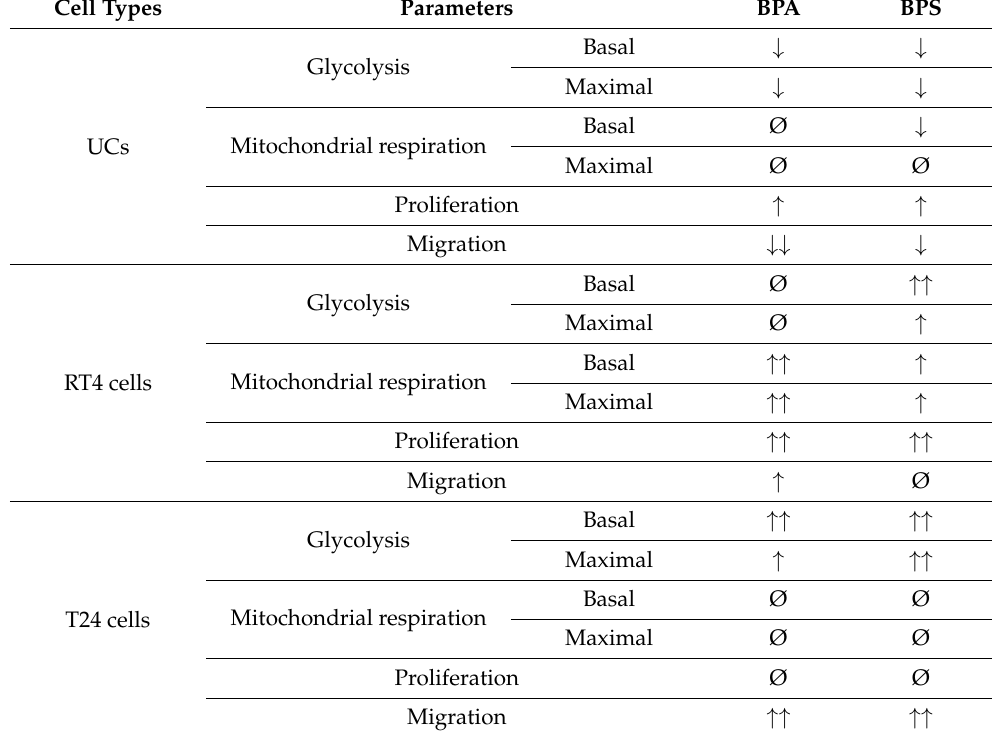
Table 1. Impact of chronic exposure to physiological concentrations of BPA and BPS on the energy metabolism, proliferation and migration of UCs and RT4 non-invasive and T24 invasive bladder cancer cells. UCs are generally negatively affected by exposure to BPs, illustrated by the decreased bioenergetics and migration. Conversely, exposure to BPs generally enhances the bioenergetics, proliferation and migration of cancer cells. Cell Types